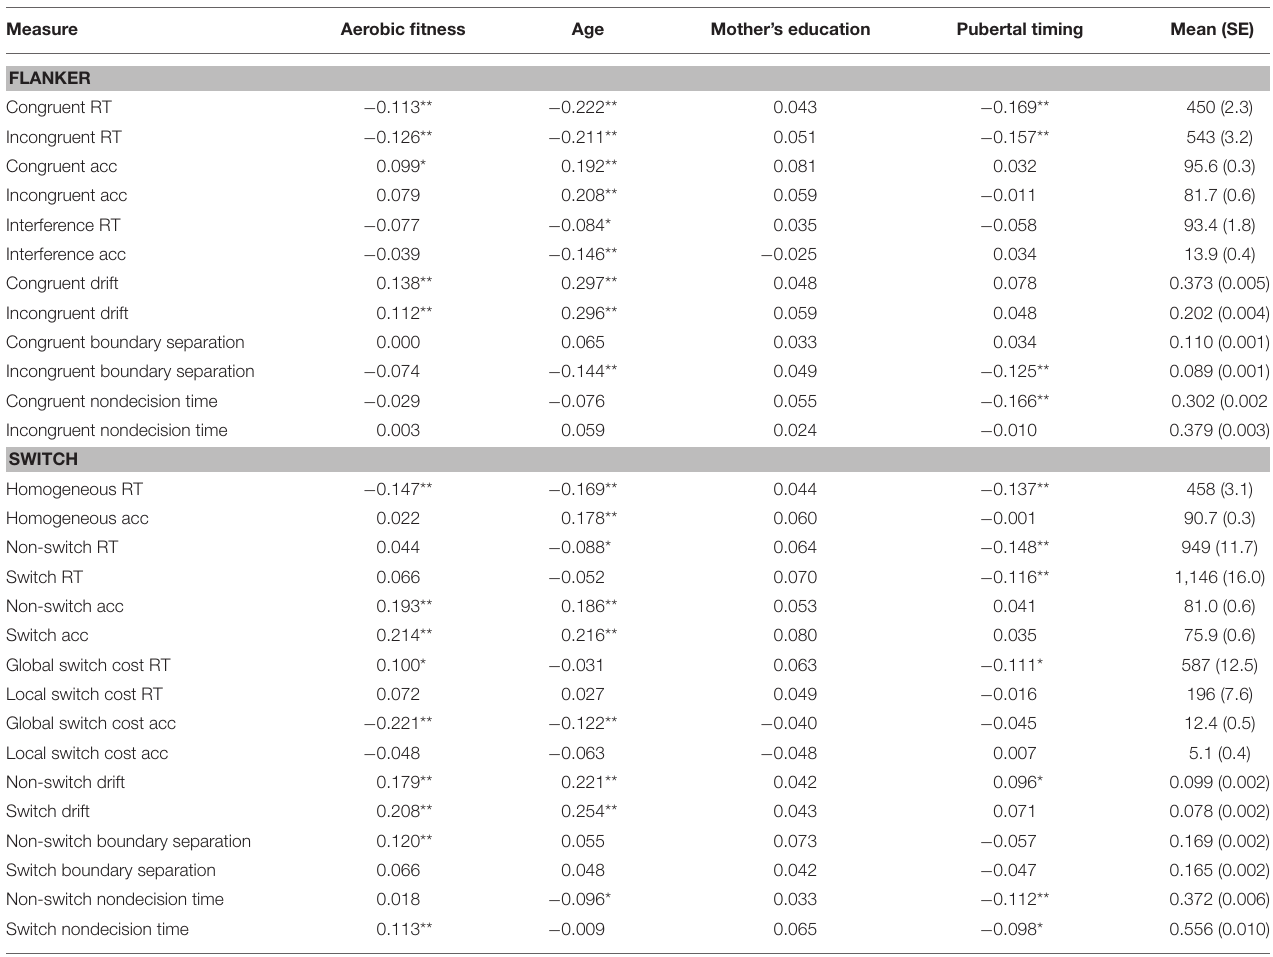
TABLE 2 | Spearman Correlations Between Dependent and Demographic Variables and Mean